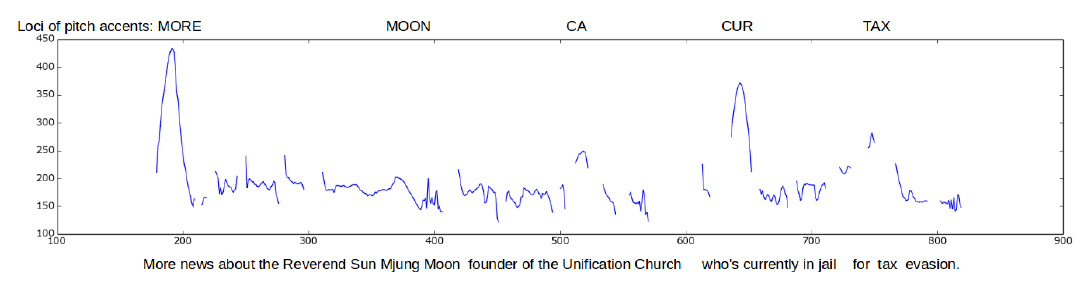
Figure 7: Pitch track for “More news about the Reverend Sun Mjung Moon, founder of the Unification Church, who's currently in gaol for tax evasion.” (BBC female radio newsreader, Aix-MARSEC corpus